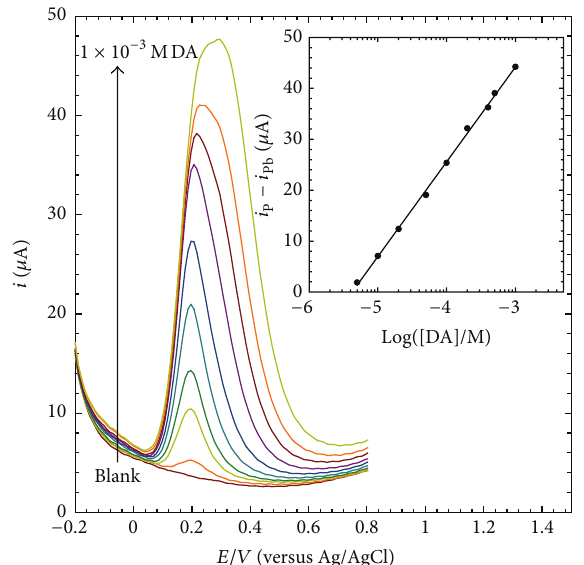
Figure 8: The square wave voltammograms obtained on the MCPE/ MNP in PBS, DA free, pH 7.0, and 0.1M NaClO 4 after 20 min pre- concentration in PBS (pH 7.0) containing 1.0 × 10 −3 M AA and different concentrations of DA; bottom to top: 0.0, 5.0 × 10 −6 , 1.0 × 10 −5 , 2.0×10 −5 , 5.0×10 −5 , 1.0×10 −4 , 2.0×10 −4 , 4.0×10 −4 , 5.0×10 −4 , and 1.0×10 −3 M DA. SWV conditions were as; pulse height (10mV), squarewaveamplitude(50 mV),andsquarewavefrequency(40 Hz). − 𝑖 )/𝜇 A = 100.1(±1.123)/𝜇 A + 18.62 Inset is calibration curve {(𝑖 p pb (±0.271) log ([ DA ]/ M ) , 𝑟 2 = 0.999} obtained from variation of the ; SWV anodic peak current as a function of DA concentration. ( 𝑖 pb anodic peak current of